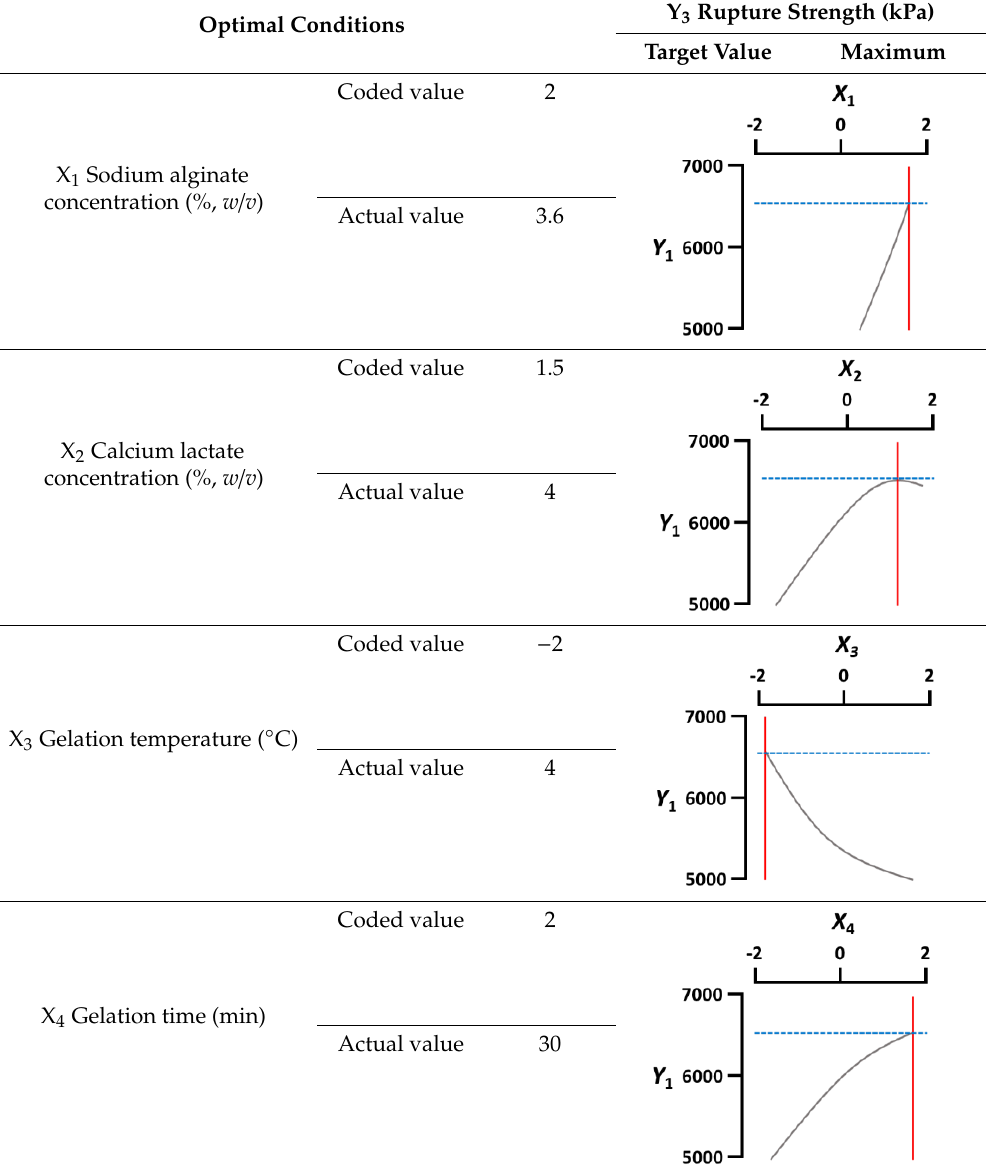
X 3 Gelation temperature ( ◦ C)